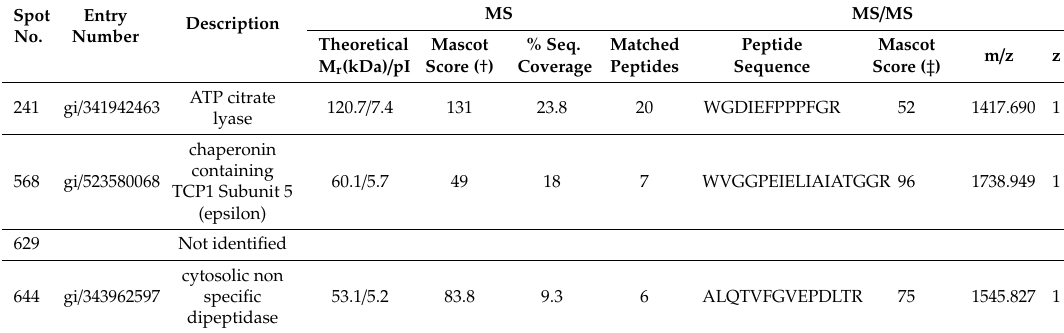
Table 3. Di ff erentially expressed proteins identified by 2-DE / MS and confirmed by tandem mass spectrometry (MS /